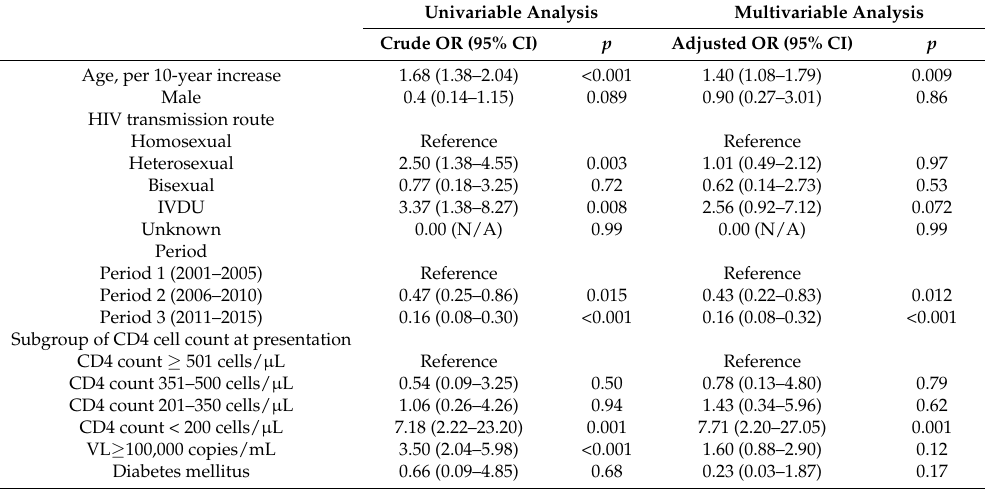
Table 3. Logistic regression model for factors associated with MTB disease at presentation among patients newly diagnosed with HIV infection from 2001 to 2015.